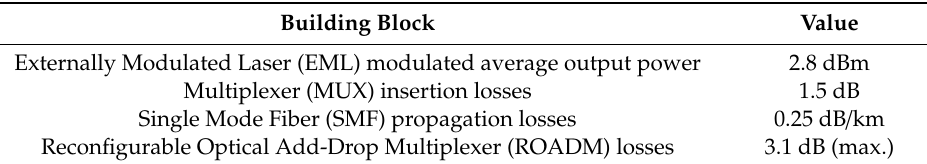
Table 2. Power budget